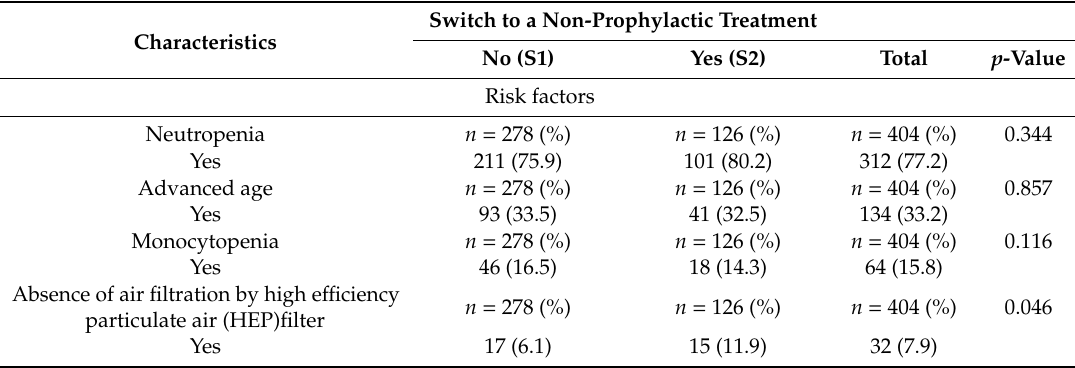
Table 2. IFD risk factors and baseline medical